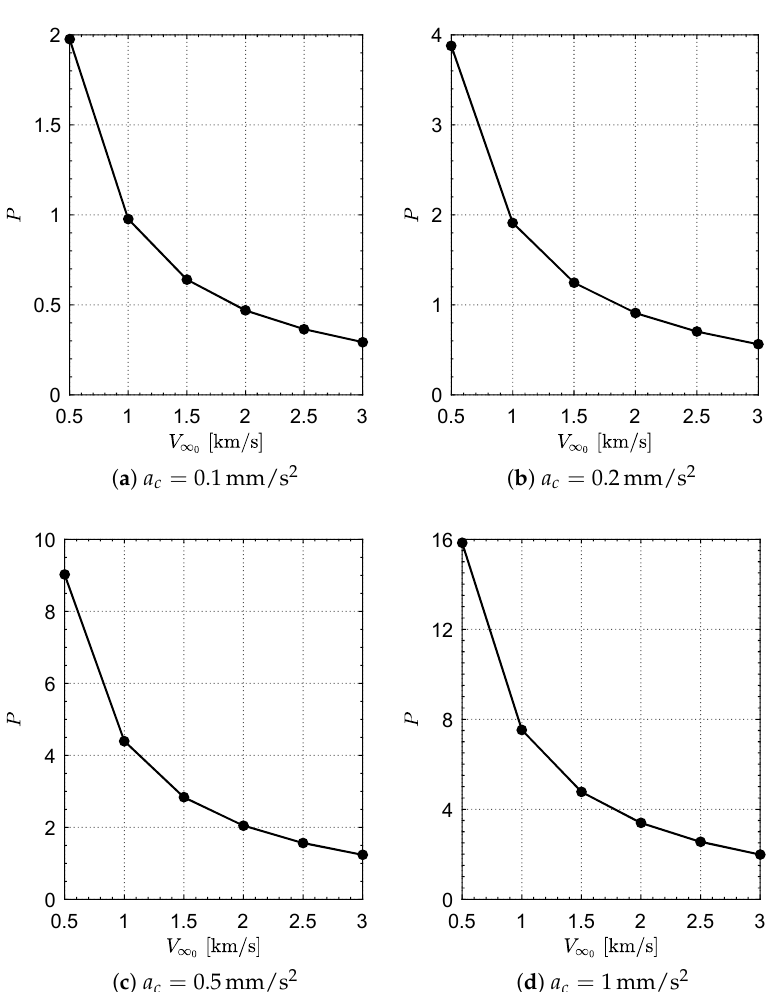
Figure 2. ∆ V -EGA performance parameters P as functions of V ∞